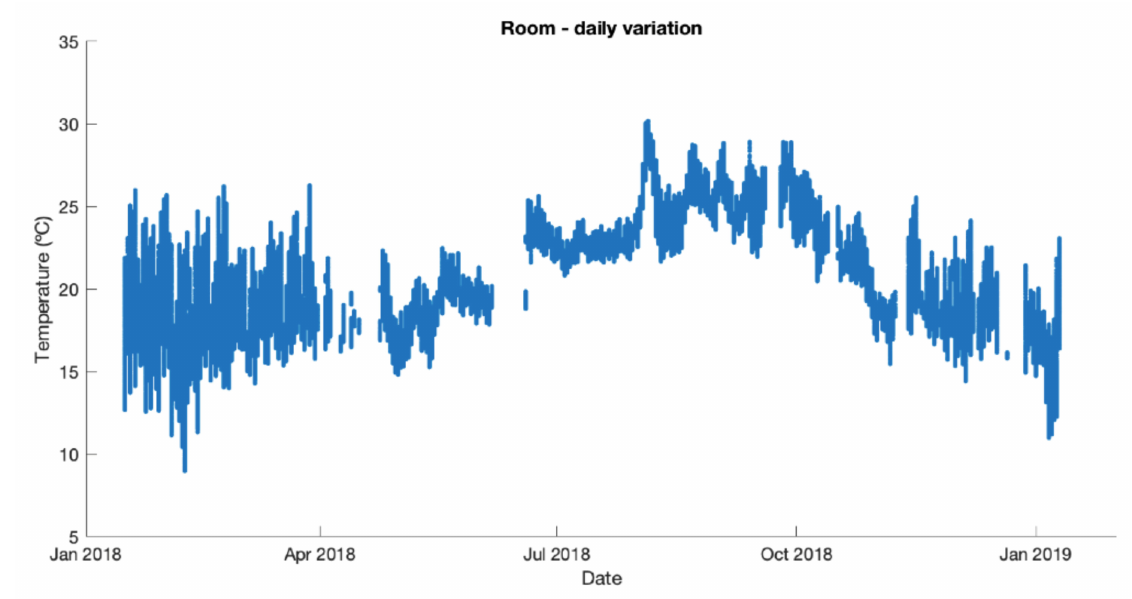
Figure 5. Yearly room temperature.